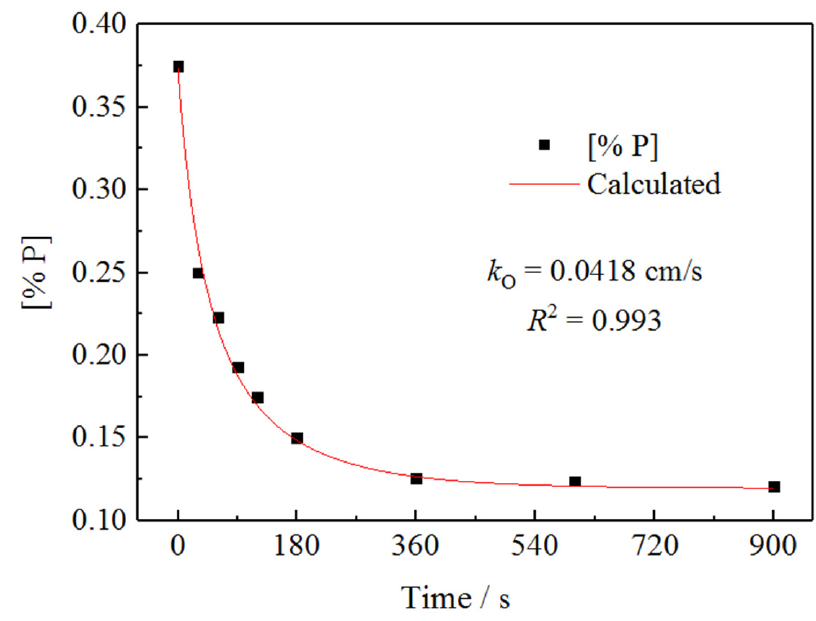
Figure 3. Fitting of Mori’s dephosphorization data (new model).